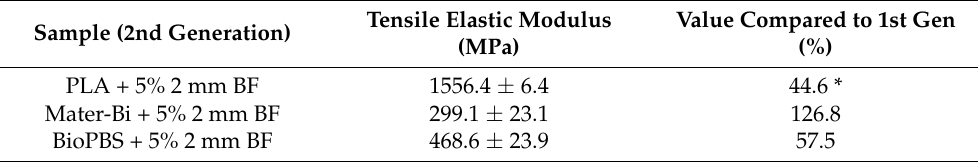
Table 14. Comparison of the tensile elastic modulus between the 2nd and 1st generations.